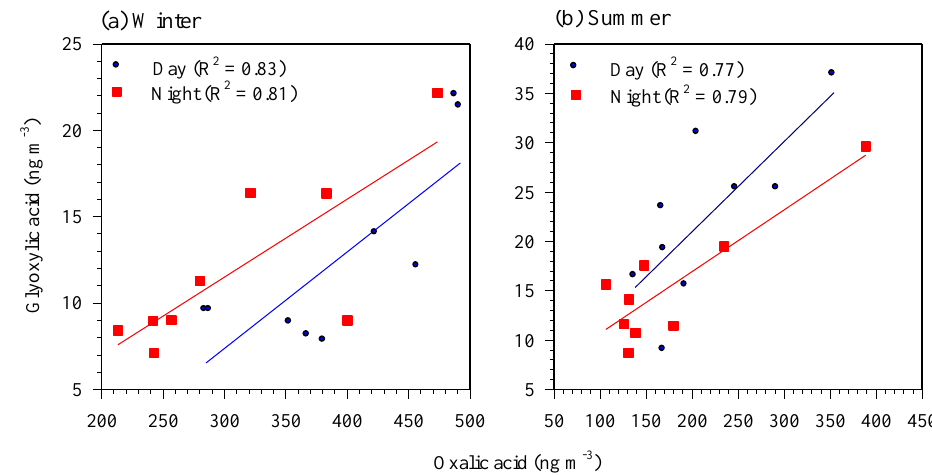
Fig. 8. Scatter plots between oxalic (C 2 ) and glyoxylic ( ω C 2 ) acids during (a) winter and (b) summer seasons showing a linear